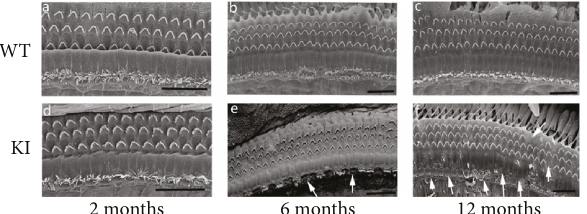
Figure 4: The degeneration of stereocilia in the Myo3a mutant mice showed by SEM. SEM images of the hair cells in Myo3a mutant and WT mice at two months old (a, d), six months old (b, e), and 12 months old (c, f). The inner hair cell stereocilium loss was found in 6-month-old Myo3a mutant mice (e), and this phenomenon becomes more serious in 12-month-old Myo3a mutant mice (f). Scale bar =20 μ m.